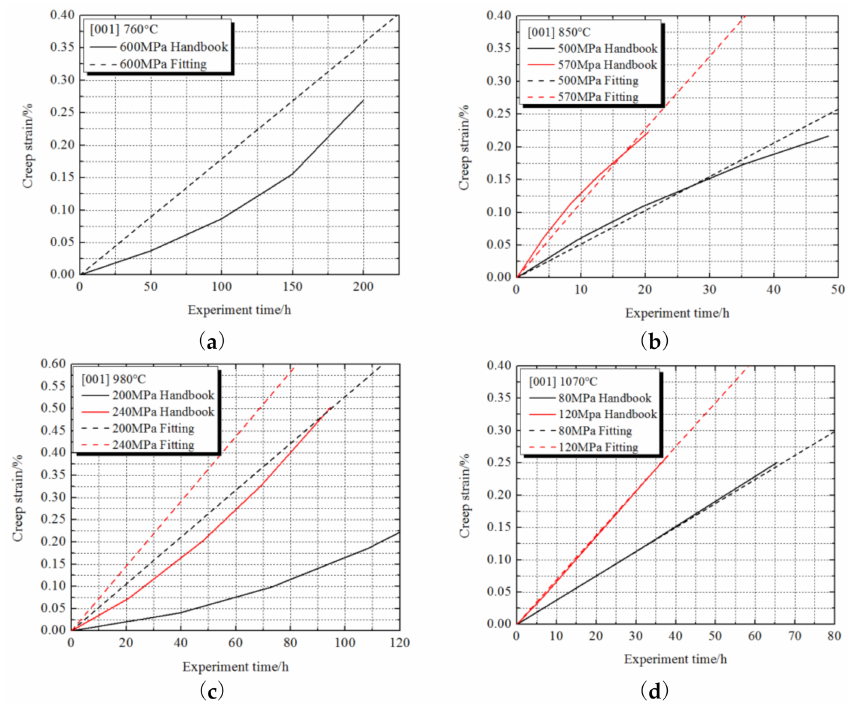
Figure 4. Creep curve fitting results of [001] orientation. ( a ) [001] 760 ◦ C, ( b ) [001] 850 ◦ C, ( c ) [001] 980 ◦ C, ( d ) [001] 1070 ◦